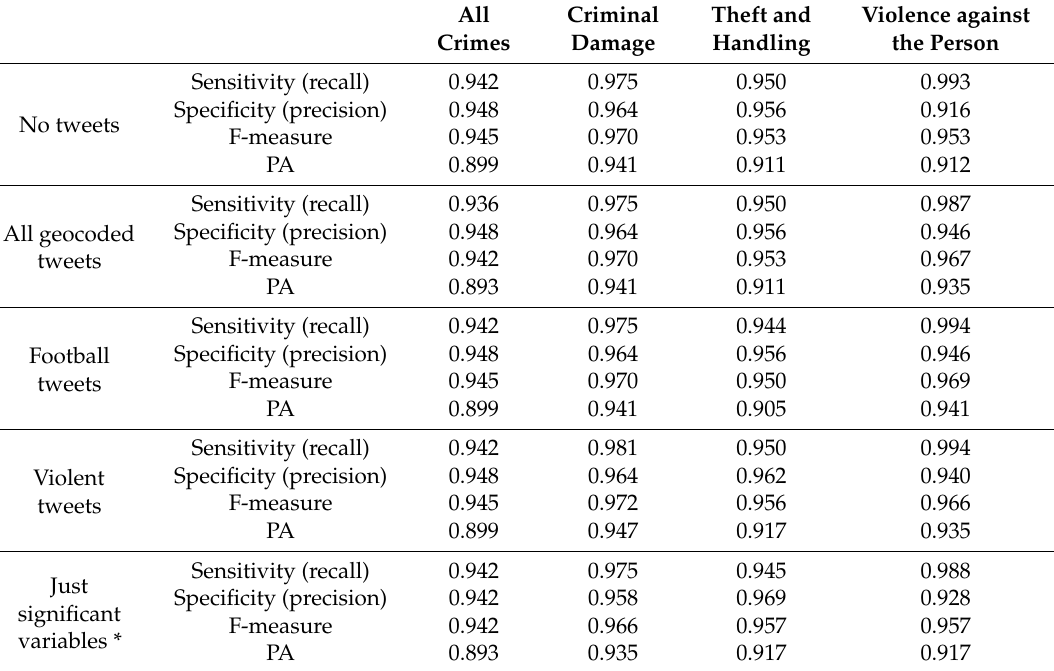
Table 5. NBLR model evaluation (* mentioned in Section